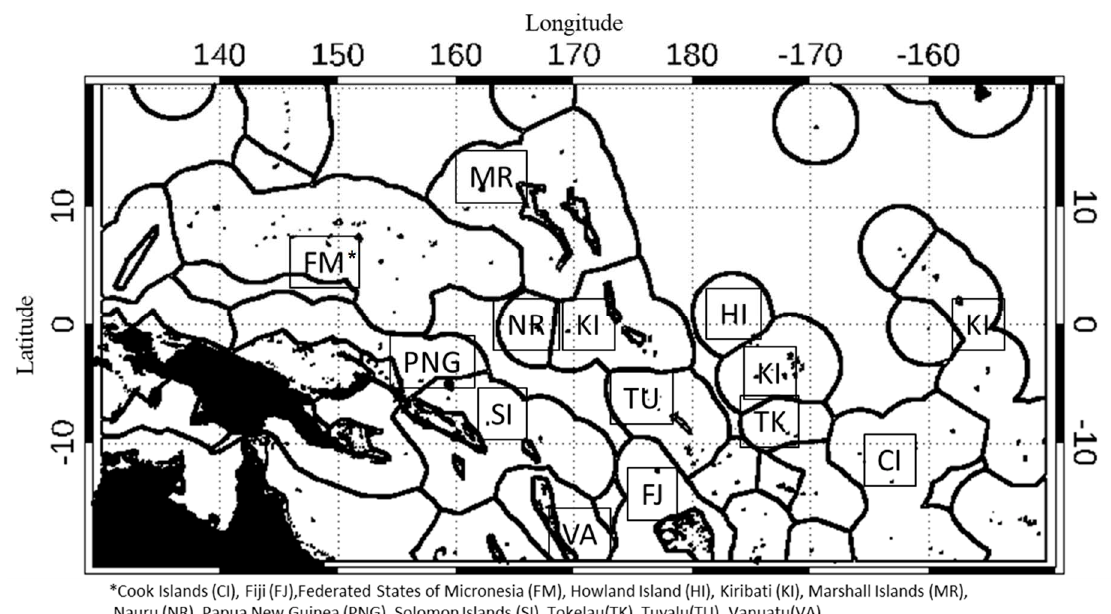
Figure 1. Map of the study area including the boundary of exclusive economic zones (EEZ) of each coastal state in the Western and Central Pacific Ocean.